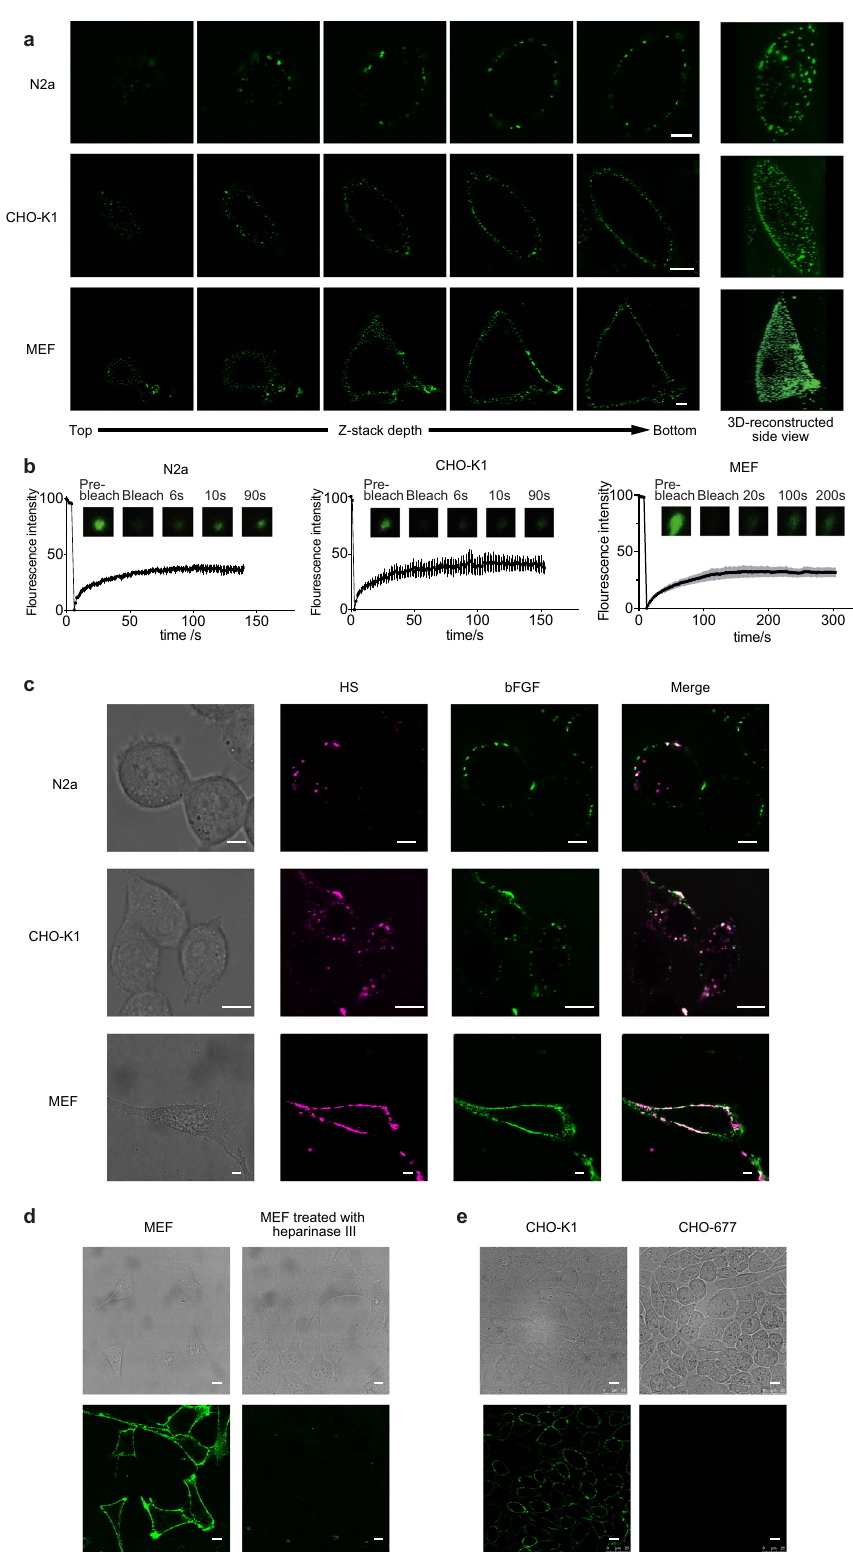
condensate amount (Fig. 3d). Moreover, in CHO-677, a cell line lacking heparan sulfate 35 , no condensate was detected, in contrast to the clear condensates observed on the CHO-K1 WT cells (Fig. 3e). These observations suggest that heparan sulphate is required for phase separation of bFGF on the cell surface. Phase separation increases effective concentration of bFGF within